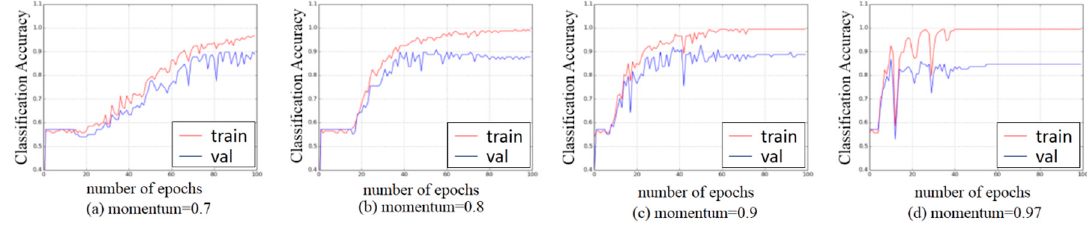
Figure 8. Comparison of classifier performance on different learning rates. ( a ) Learning rate = 0.0001; ( b ) Learning rate = 0.001; ( c ) Learning rate = 0.01; ( d ) Learning rate = 0.1.